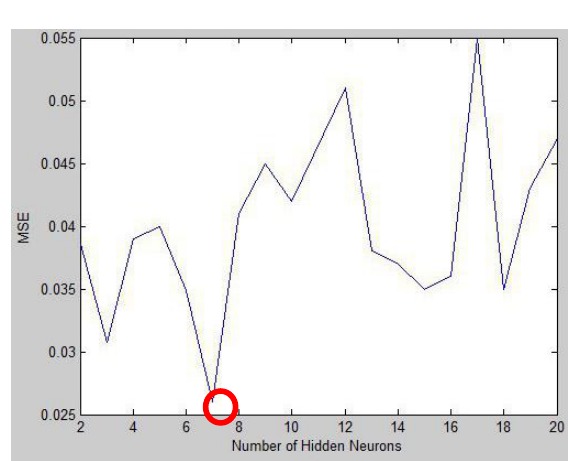
Figure 8. Evaluating the number of nerouns to MSE